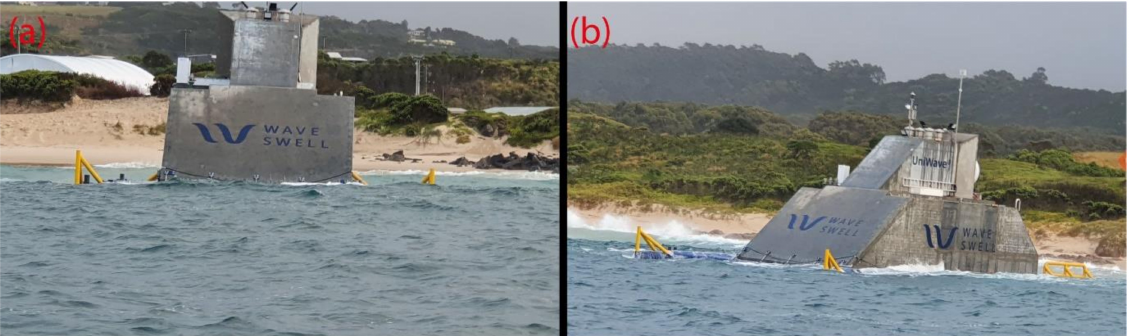
Figure 8. Above-water photographs of the OWC WEC at Location 1 at approximately 7 a.m. on 18 January 2021. ( a ) Head-on image from a Southern perspective. ( b ) Side view from a South- Eastern